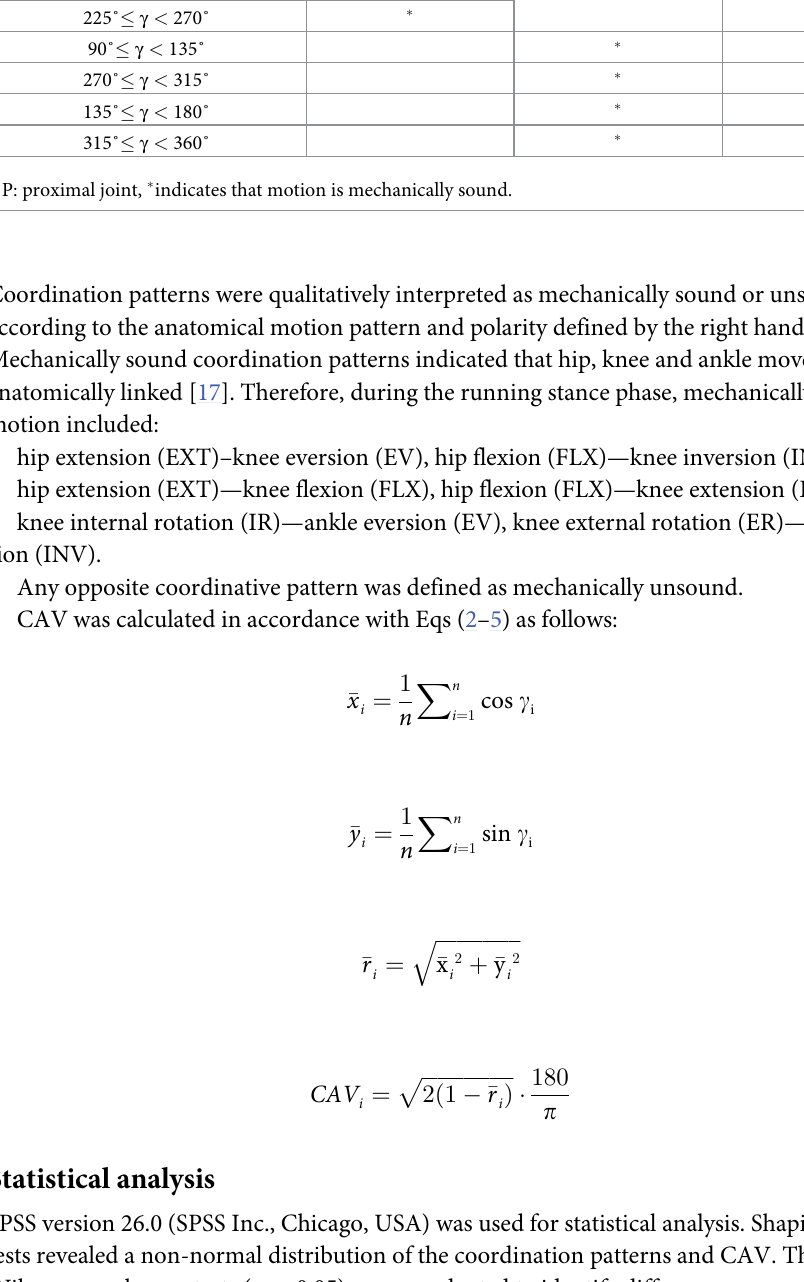
Table 1. Classification of coordination patterns. Coordination pattern